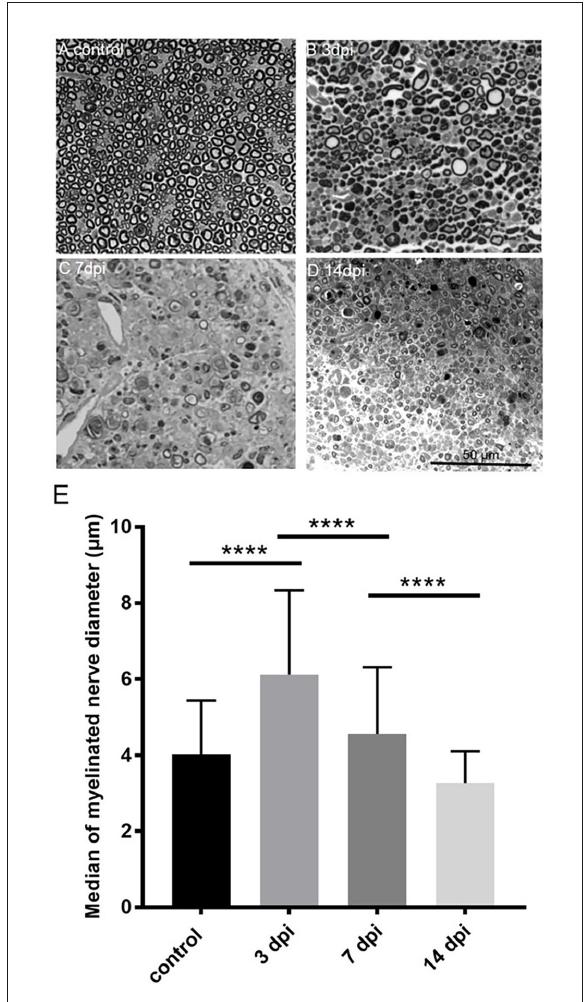
FIGURE4 Temporal change of semi-thin sections in the PBS injected group (ipsilateral side) and intact sciatic nerve (contralateral side). Semi-thin cross-sections 1 µ m in thickness of the crushed sciatic nerve injected with PBS distal to the injury site were stained with toluidine blue. The representative figures are from (A) intact sciatic nerve of sham surgery (contralateral). (B) Ipsilateral sciatic nerve 3 days after crushing injury. (C) Ipsilateral sciatic nerve 7 days after crushing injury. (D) Ipsilateral sciatic nerve 14 days after crushing injury. (E) Medians of myelinated nerve diameter from different groups. Data are represented as median ± SD ( n : control = 7, 3 dpi = 4, 7 dpi = 3, 14 dpi = 3), **** p < 0.0001, dpi: day post-injury. Data obtained from the sham surgery (contralateral) side was denoted as “control” in this figure. Compared with intact myelinated nerves of the control group, the median of myelinated nerve diameter increased in 3 days after crushing injury but decreased in 7 and 14 days after crushing